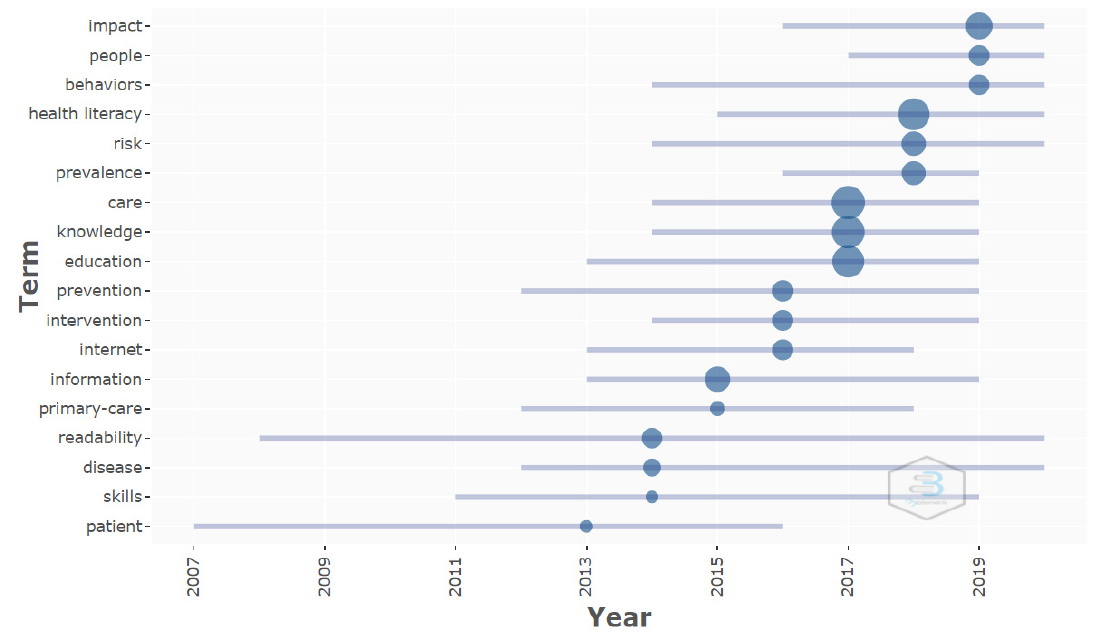
Figure 9. Trend topics authors’ KeyWords Plus.